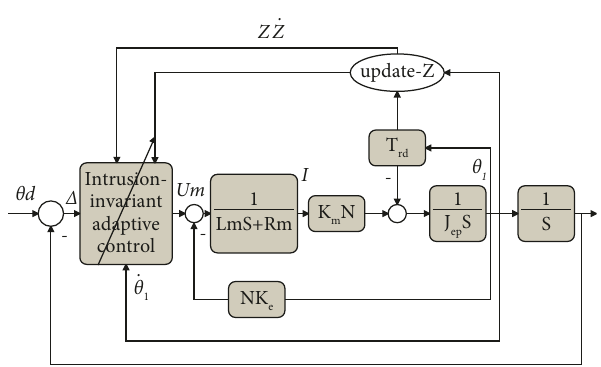
Figure 3: Schematic diagram of the adaptive position control system based on immersion